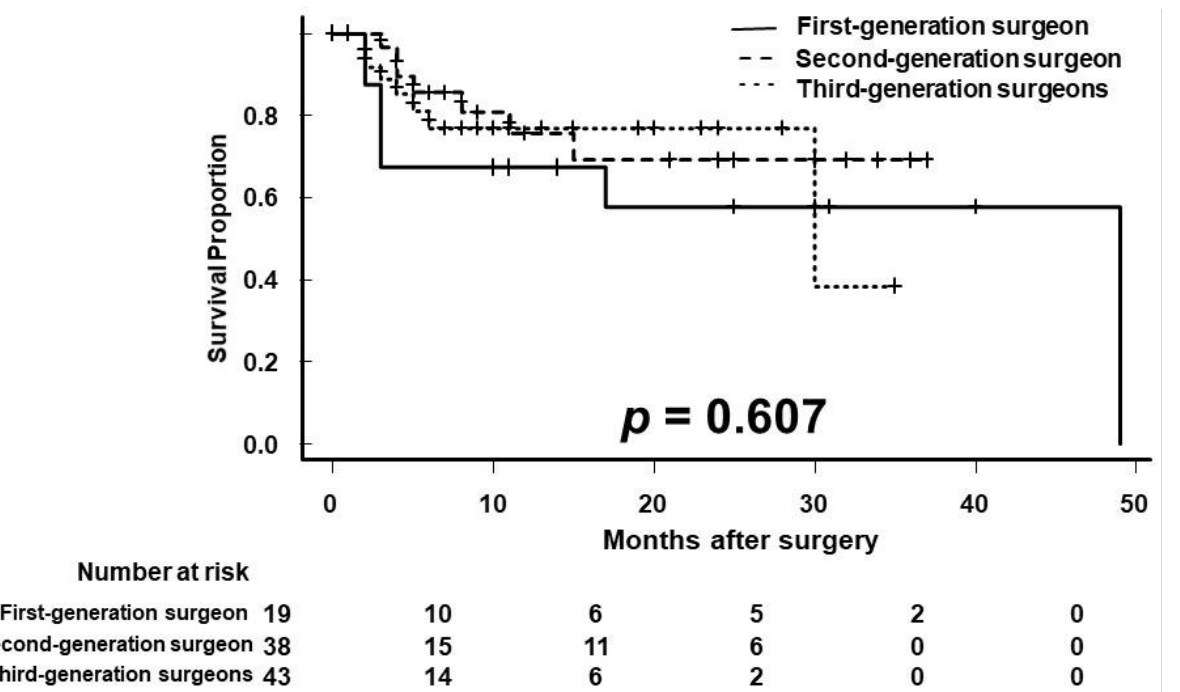
Figure 3. Kaplan–Meier analysis of recurrence-free survival (RFS). The 1-year RFS was 67.3%, 75.5%, and 76.8% in the first-, second-, and third-generation surgeons, respectively.